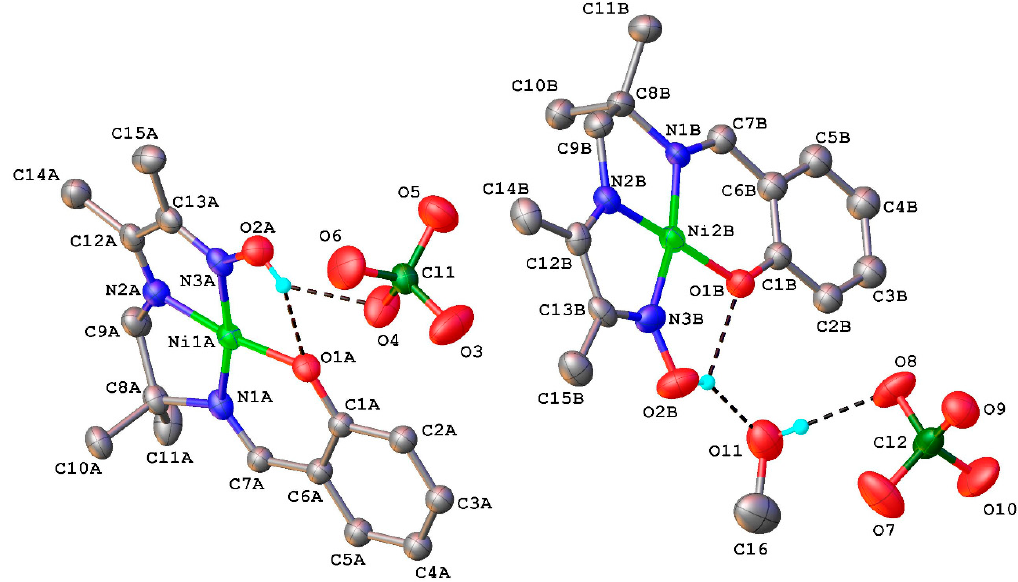
Figure 3. View of the asymmetric unit in the crystal structure 3 with atom labelling scheme and thermal ellipsoids at 40% probability level. Non-relevant H-atoms are omitted. Selected bond lengths (Å) and angles ( ◦ ): Ni1A–O1A 1.7996(17), Ni1A–N2A 1.826(2), Ni1A–N1A 1.828(2), Ni1A–N3A